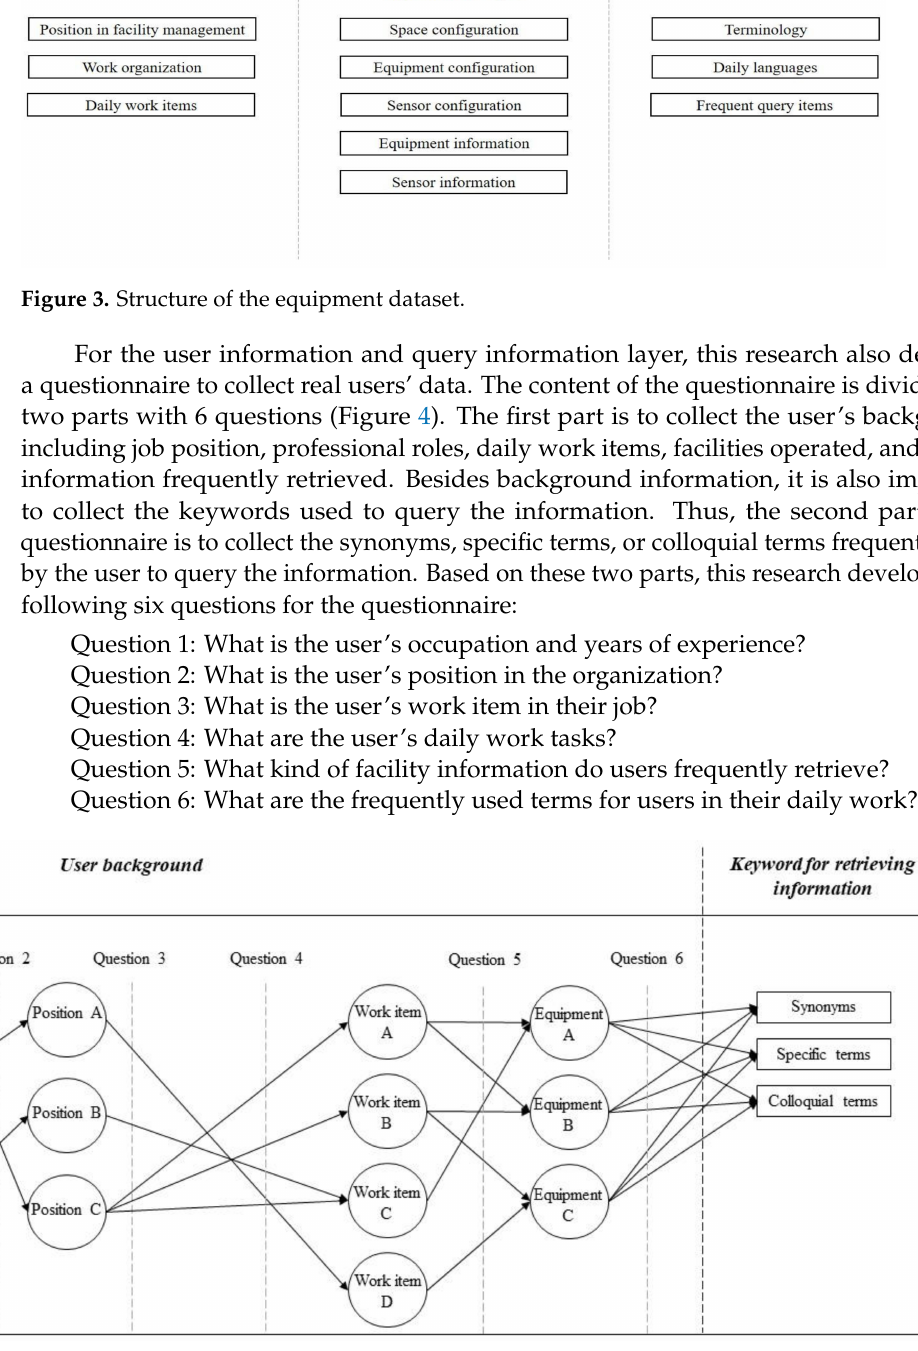
Figure 4. Contents of the user interview